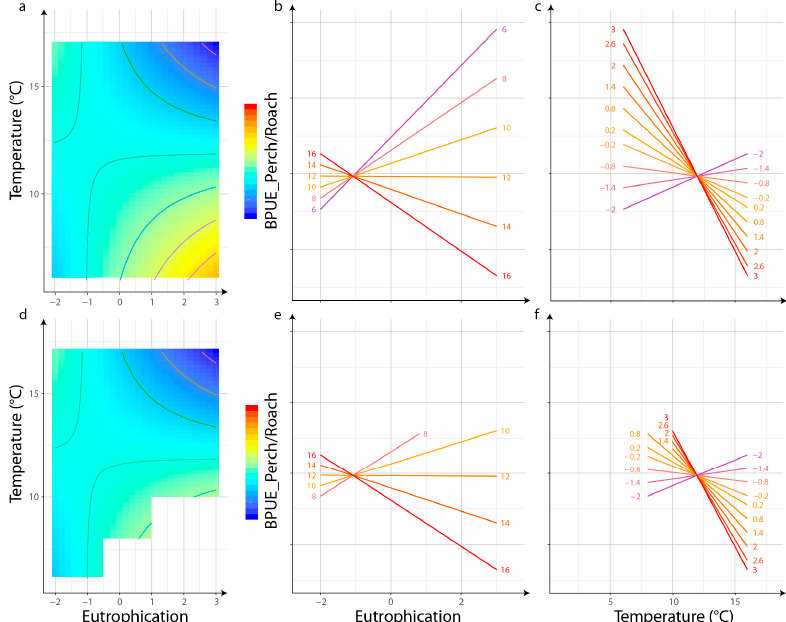
E ff ect of interaction between average temperature and eutrophication level on Figure 2. Effect of interaction between average temperature and eutrophication level on BPUE_Perch / Roach metric (log) when considering all possible combinations of pressures ( a – c ), or when BPUE_Perch/Roach metric (log) when considering all possible combinations of pressures ( a–c ), or considering only the observed combination of pressures (see Figure 1) ( d – f ). ( a , d ) Low theoretical when considering only the observed combination of pressures (see Figure 1) ( d – f) . ( a , d ) Low values are represented in blue and high theoretical values in theoretical values are represented in blue and high theoretical values in red.